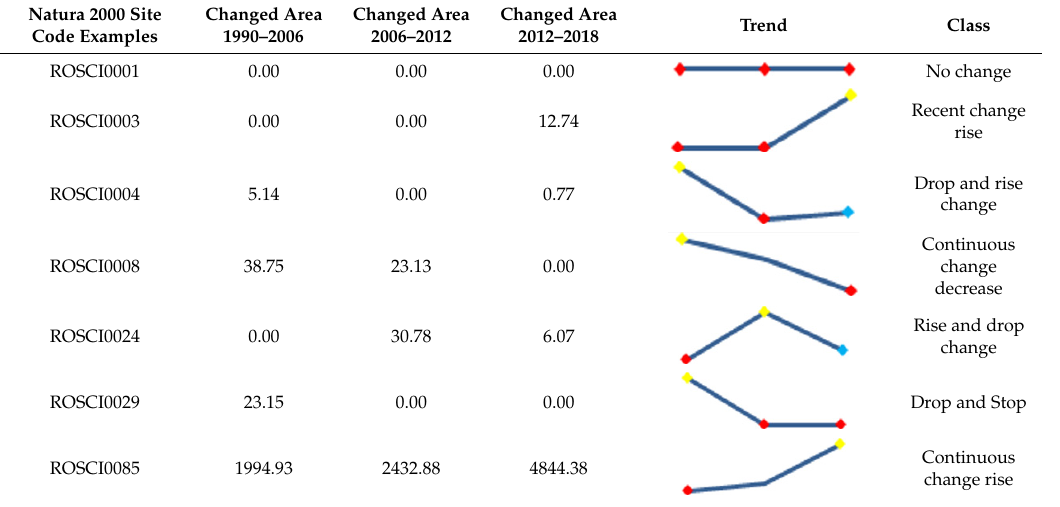
Table 2. CLC patterns of dynamic behavior types—ROSCI sites sample.